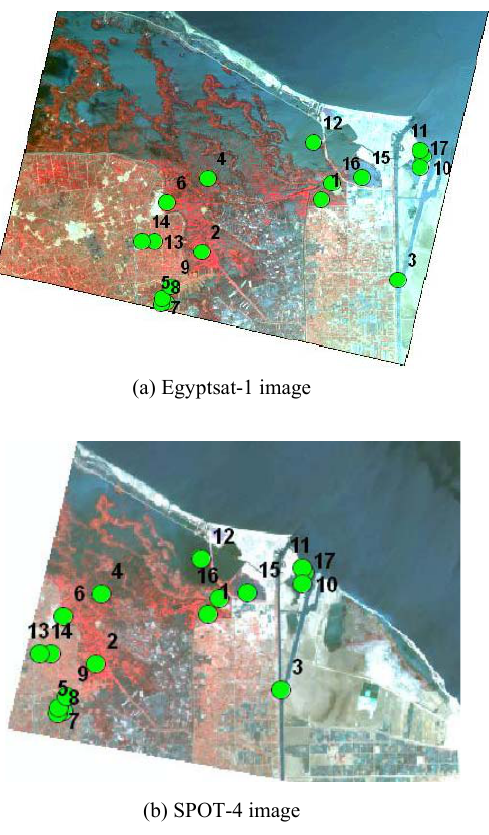
Figure 1. Equivalent images of Port Saied area, Egypt 2- We identified the maximum possible number